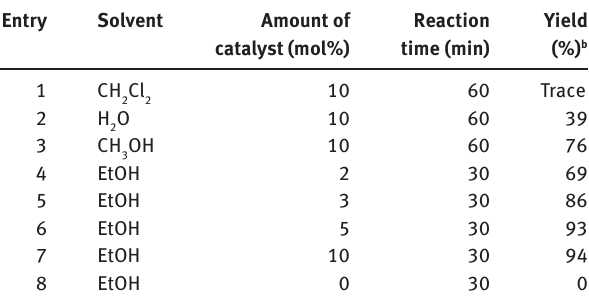
Scheme 2 Mannich reactions of ketones, benzaldehyde and aniline.